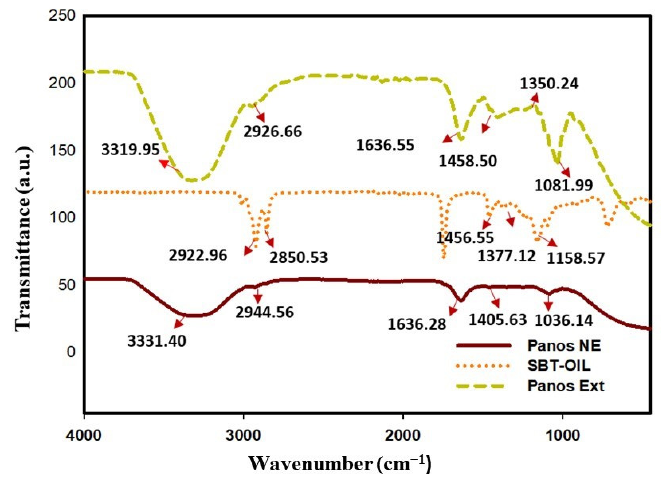
Figure 2. FT-IR spectra of Panos nanoemulsion show Panos NE (Red line), Panos extract (Green line), and Sea buckthorn oil (Yellow line).